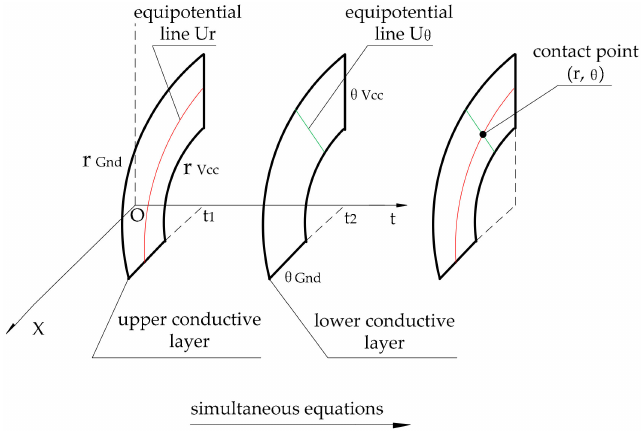
Figure 8. Principle of position detection.